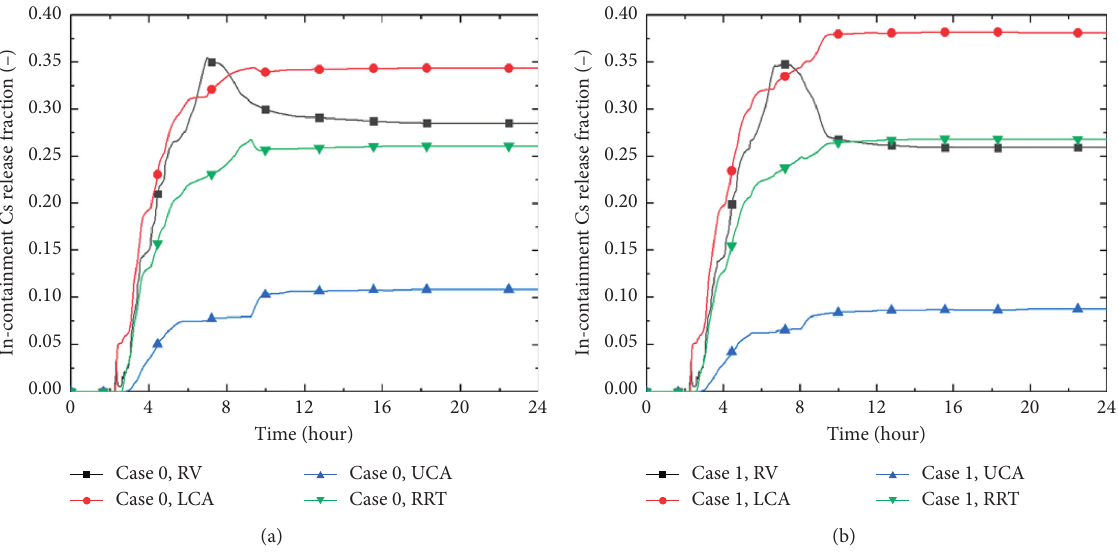
Figure 8: In-containment cesium release fraction: (a) case 0 and (b) case 1.